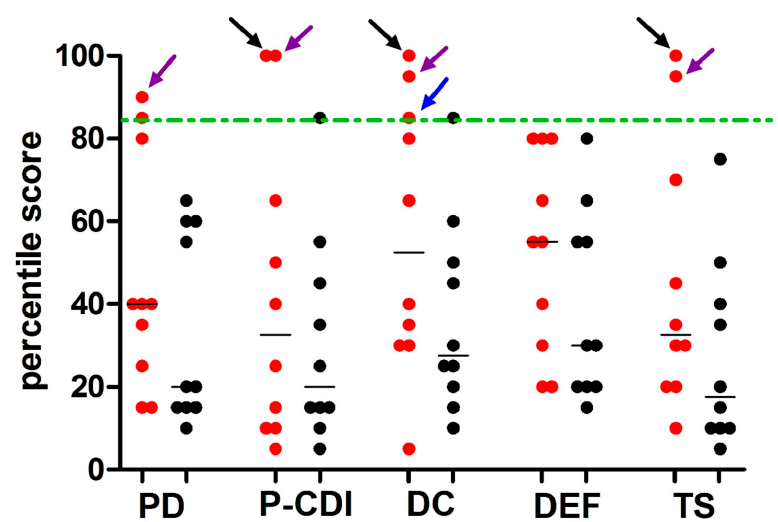
Figure 1. Distribution of PSI-SF percentile scores of subscales and total score from PCD mothers and controls. Legend: the parenting stress index-short form questionnaire (PSI-SF) was used to explore the stress levels in the mothers of primary ciliary dyskinesia (PCD) patients (n = 10) and of healthy controls (n = 10) younger than 15 years. The PSI-SF is organized intofour subscales: parental distress (PD), parent-child dysfunctional interaction (P-CDI), di ffi cult child (DC), defensive responding (DEF). Each point (red and black for PCD patients and controls, respectively) represents the percentile score taken from a single participant. Horizontal bars represent the median values. Dashed lines indicate the 85th percentile (high stress level). Only 3 PCD mothers presented a pathologic percentile score: one (purple arrow) reported pathologic percentile score in PD, PCDI, DC subscales and in total score (TS); one (black arrow) reported pathologic percentile score in PCDI, DC and TS; one (blue arrow) reported a score equal to 85th percentile only in DC subscale. Both in subscales score and total score, the percentiles were not significantly di ff erent between patients and healthy controls ( p > 0.05). Table 3. Results of the PGWBI questionnaire administered to Group B patients and controls.